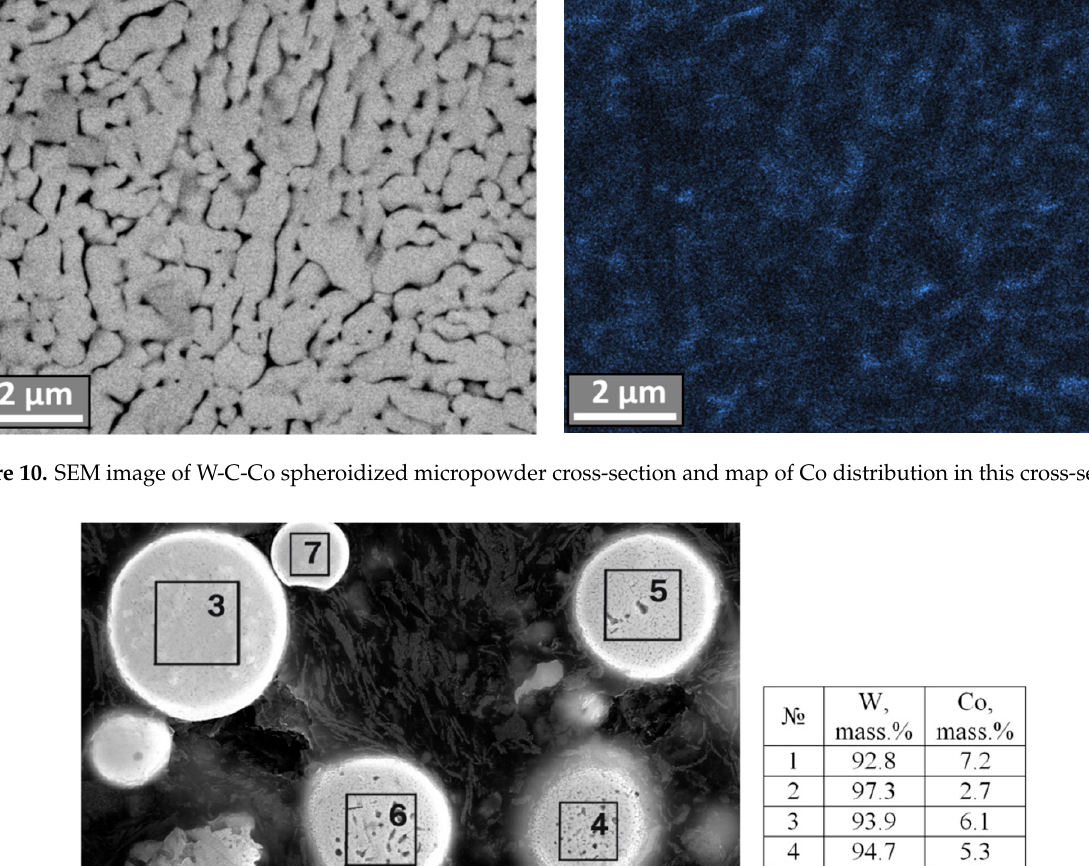
11 of 13 According to the EDS results of individual micropowder particles cross-sections with the most characteristic morphology revealed that the cobalt in them is uniformly distrib- uted at submicron level in accordance with the structure of the particle (Figure 10).